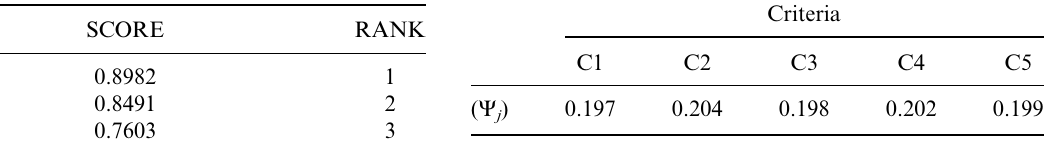
Table 5. The overall preference selection index and project